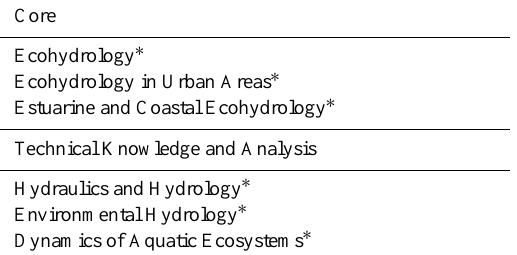
Table 2. Example course list from the Erasmus Mundus Ecohy- drology MSc Program (www.ecohyd.org) offered in cooperation between the University of Algarve (Portugal), University of Lodz (Poland), University of Kiel (Germany), UNESCO-IHE Institute for Water Education (The Netherlands), and National University of the Plata (Argentina). Students in this two-year MSc program take three semesters of courses in at least two of the participating institutions (plus a summer program in Argentina) and then conduct their thesis research at one these institutions or another cooperating institute. Courses with an asterisk (*) are compulsory, depending on the mo- bility scheme of the student. Others are